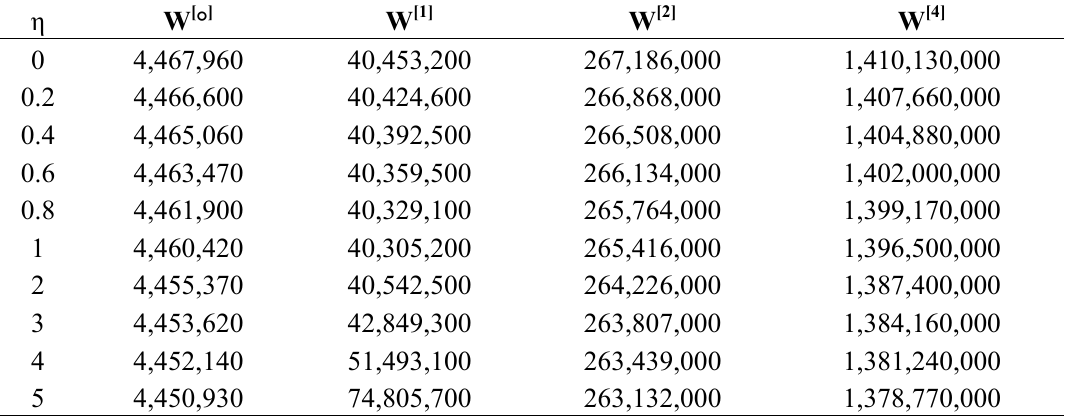
Table 1. Numerical values abstracted from topological potentials of Equations (21)–(24) then used to generate the interpolations polynomials of Equations (27)–(34) as a function of the η -step of the forming ( η = 0,0.2,0.4,0.6,0.8,1) and propagation ( η = 0,1,2,3,4,5) of the SWw dipole in the periodic nanoribbon supercell E of the of Figure 2, respectively, see